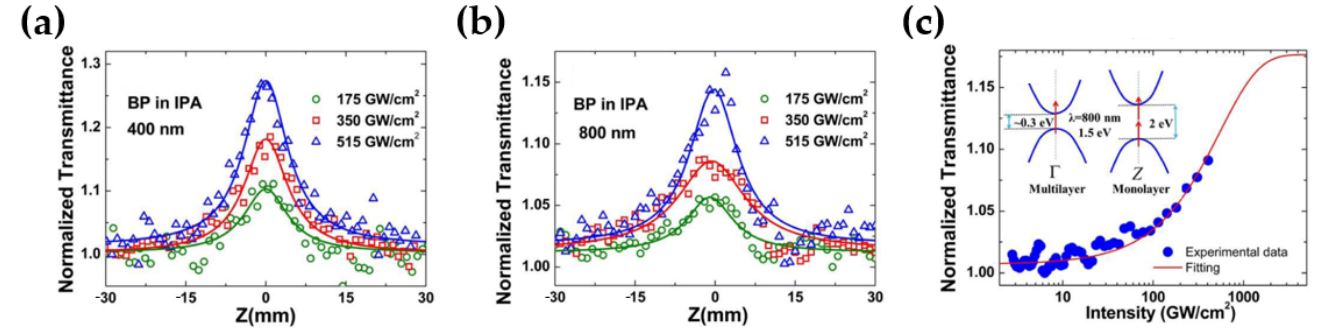
Figure 9. Broadband nonlinear optical absorption of BP dispersions. The open-aperture Z-scan measurements of dispersions of BP nanoplatelets under different intensities at 400 ( a ) and 800 nm ( b ), respectively; ( c ) relation between normalized transmittance and input intensity for dispersions of BP NPs at 800 nm. (Reproduced with permission from ref. [137]. Copyright 2015 OSA Publications).